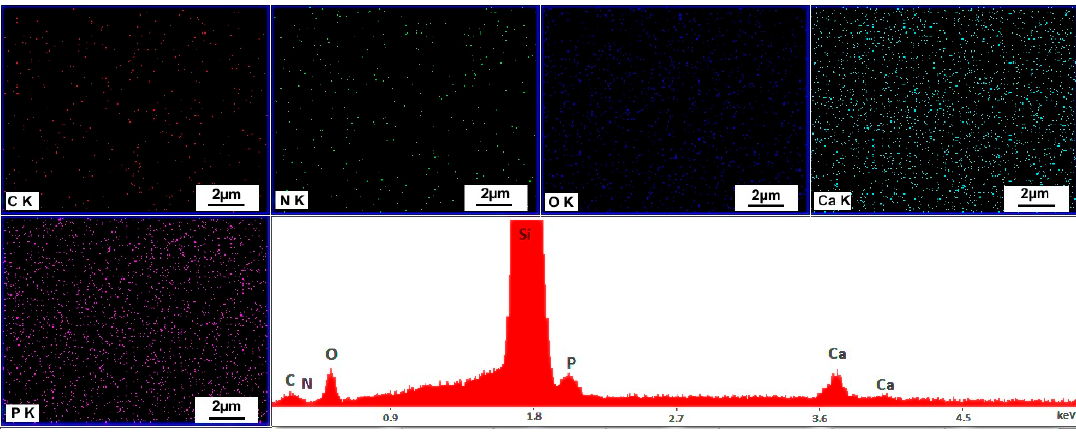
Figure 6. Elemental mapping and typical EDX spectrum of CS–HAp coatings obtained at p = 2 × 10 − 3 mbar.